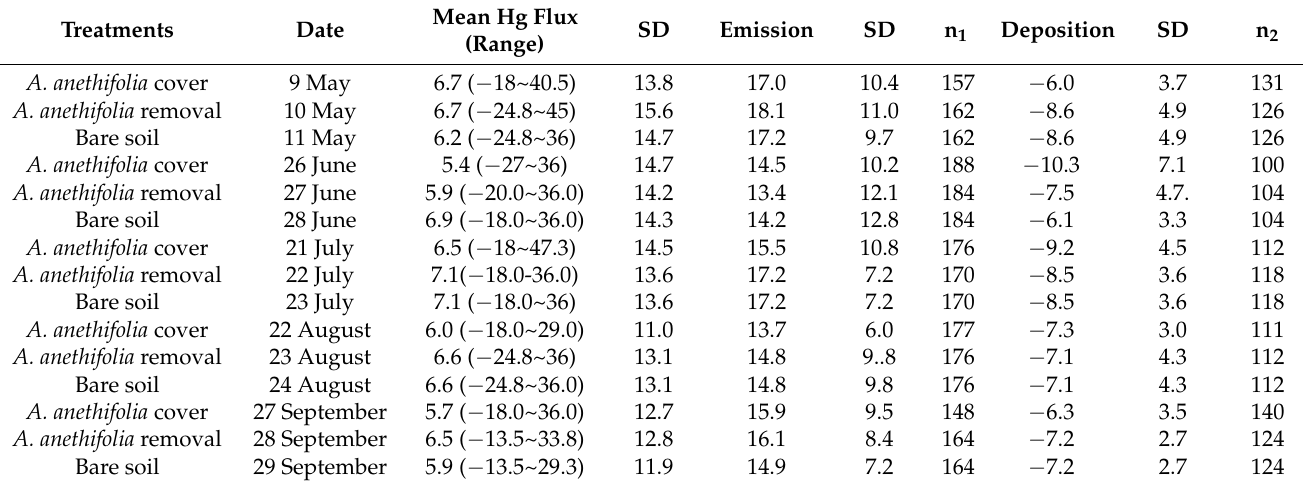
Table 3. Soil-air Hg exchange fluxes (ng · m − 2 · h − 1 ) for diel and the separate released and deposited periods based on measurements during the three treatments (n = 288, n = n 1 + n 2